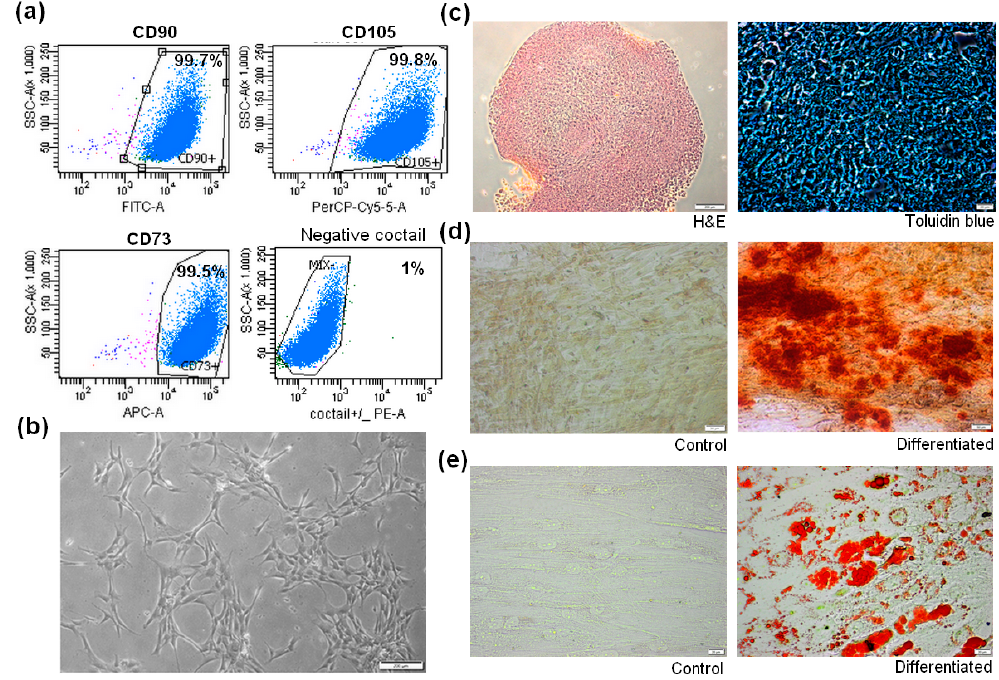
Figure 1. Identification and morphology of human bone marrow-derived mesenchymal stromal cells